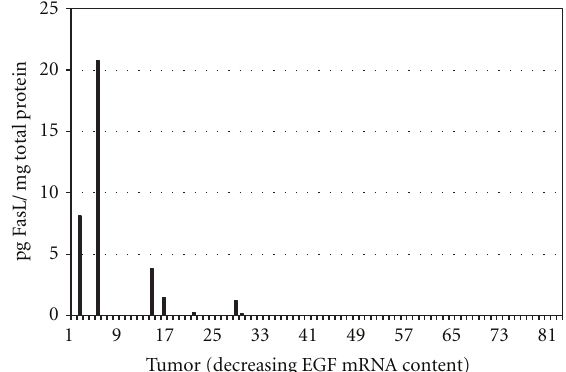
Figure 3: Distribution of EGF protein in 21 sarcomas included within the 82-sarcoma cohort. Figure 4: Distribution of FasL protein in 21 sarcomas within the 82-sarcoma